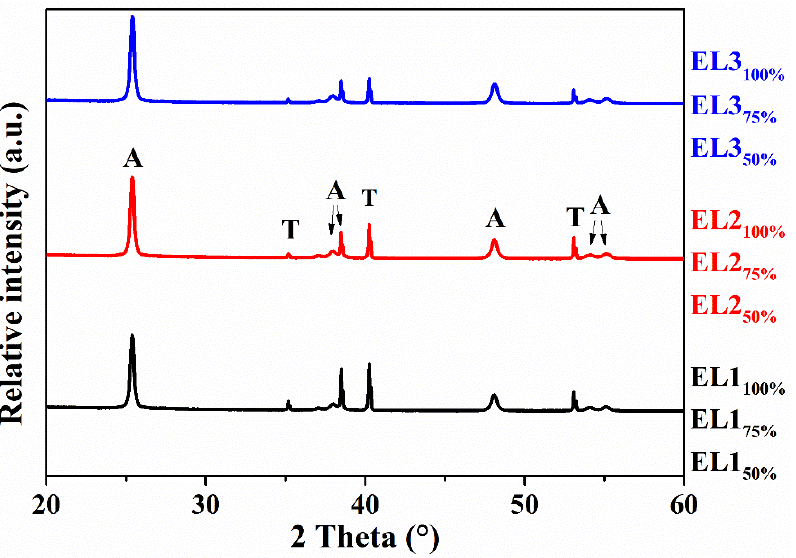
Figure 2. XRD patterns of TNS prepared in different electrolytes (according to Table 1) at 60 V. A—anatase;